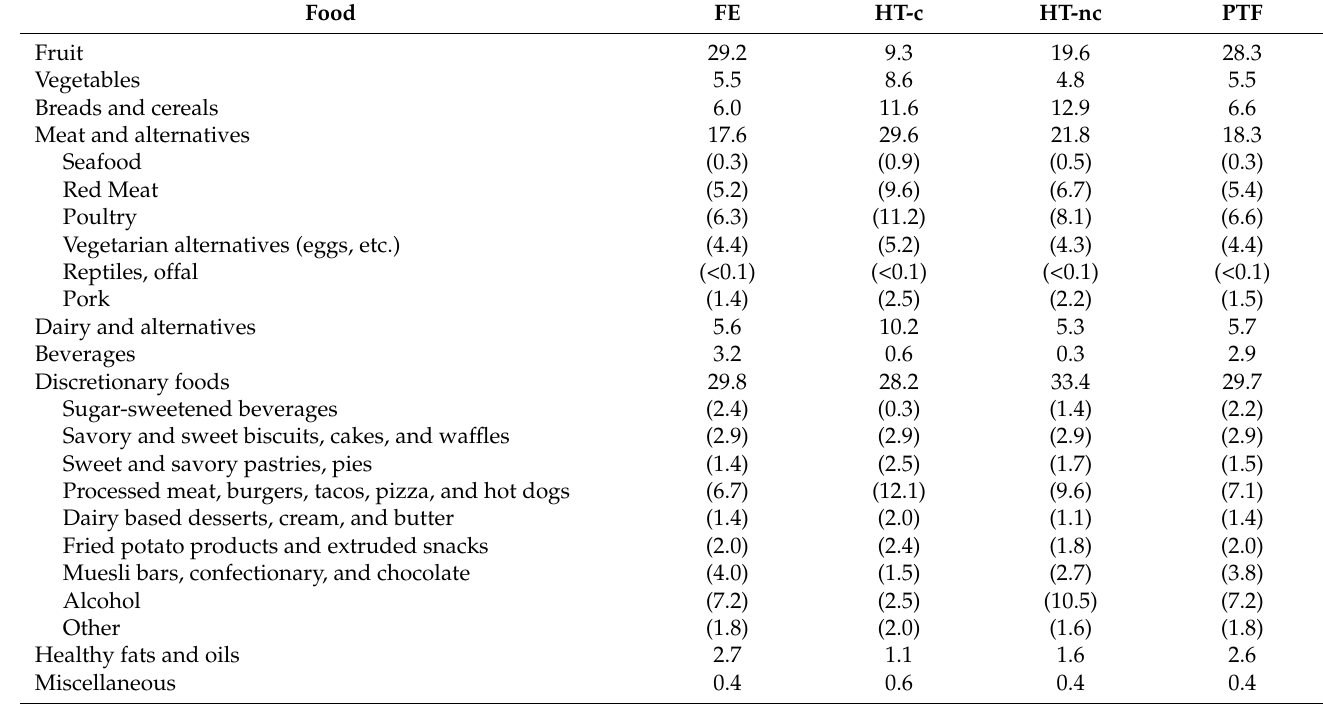
Table 1. Freshwater ecotoxicity (FE), human toxicity carcinogenic effects (HT-c), human toxicity noncarcinogenic effects (HT-nc), and pesticide toxicity footprint (PTF). Food groups are as defined by the Australian Dietary Guidelines. Food